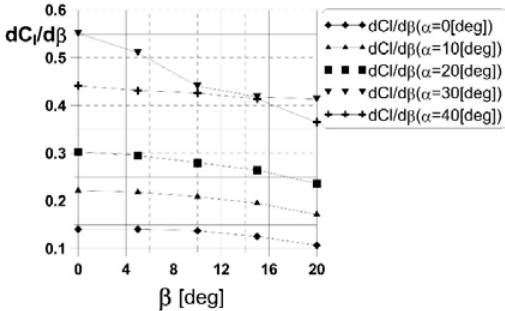
Fig. 17. Stability derivatives ∂C l /∂β – roll moment coefficients versus sideslip